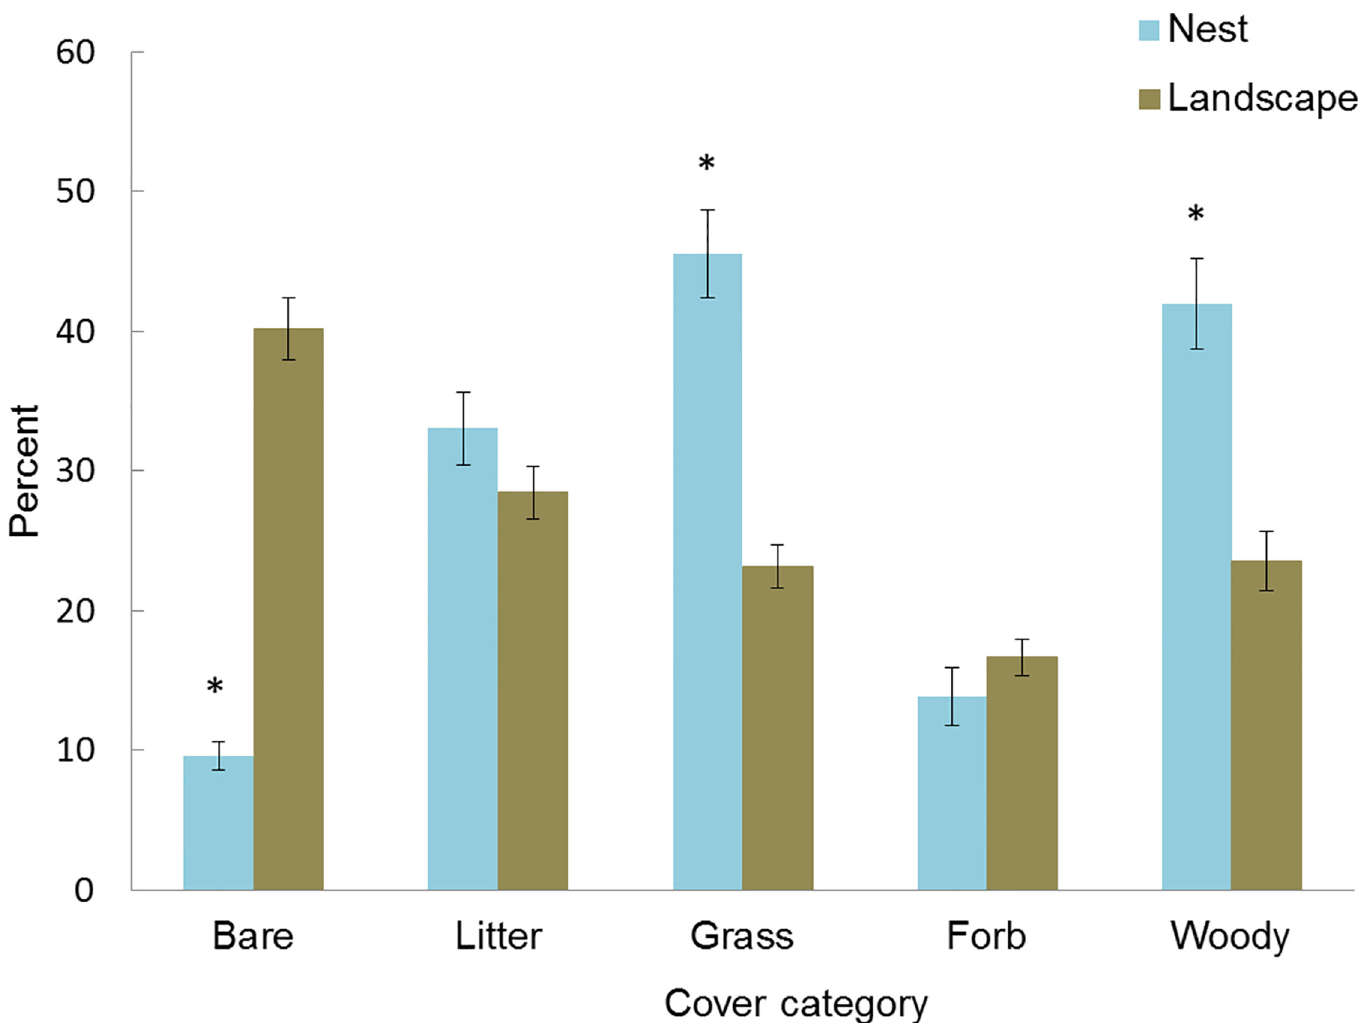
Fig 5. Vegetation characteristics vary among nest and landscape sites. Percent vegetation cover measured at northern bobwhite nest (n = 87) and landscape sites (n = 205) at the Packsaddle WMA, Oklahoma, USA (2013 – 2014). Asterisks denote significant differences at the p < 0.05 level within cover